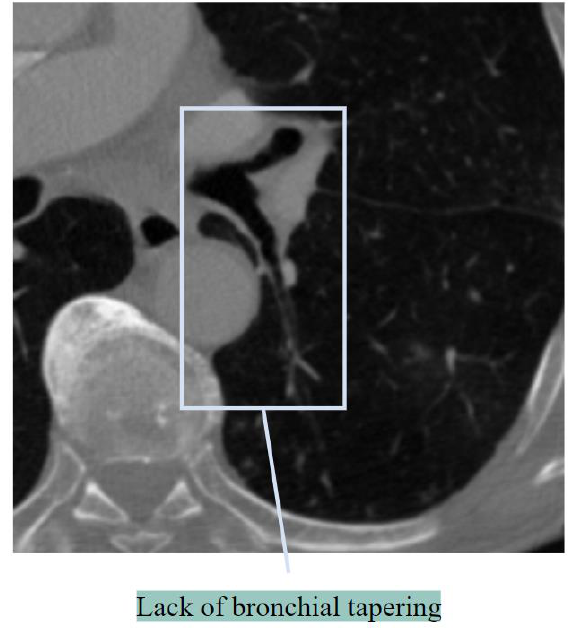
Figure 4. Lack of bronchial tapering.